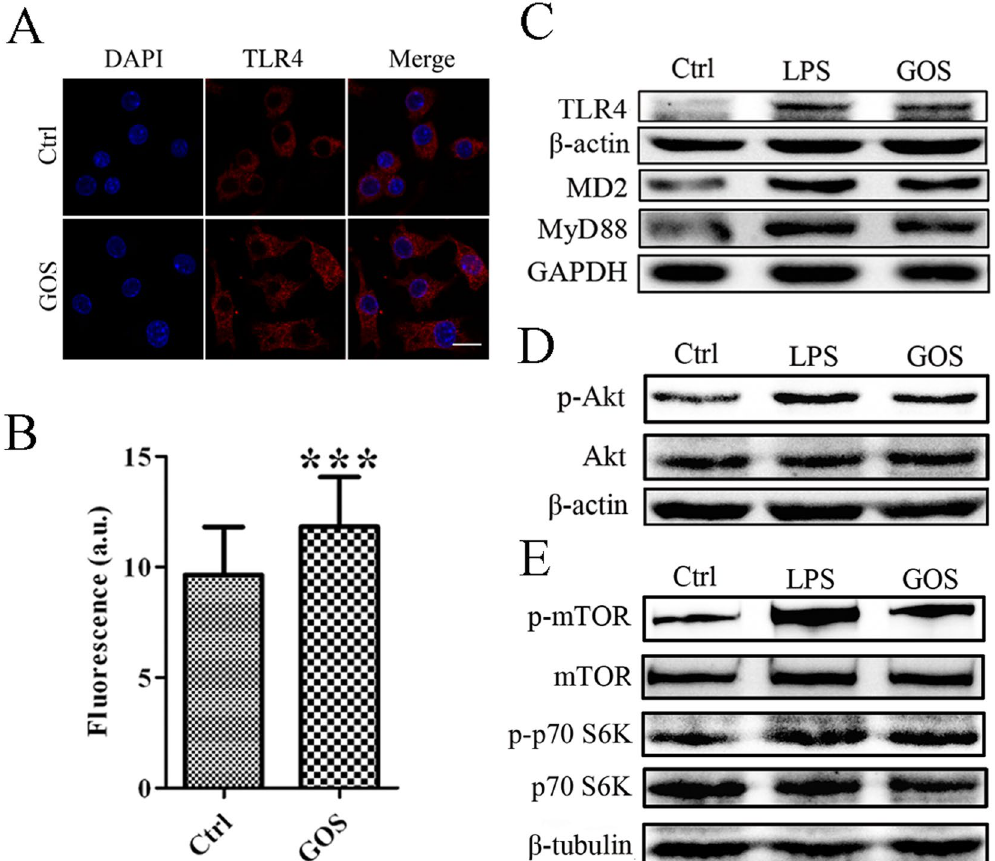
Figure 2. GOS increases TLR4 expression and stimulates Akt/mTOR activation in RAW264.7 cells. ( A ) RAW264.7 cells were treated with 1 mg/ml GOS for 24 h, and TLR4 expression was evaluated by immunofluorescence analysis using an anti-TLR4 antibody. DAPI was used to label nuclei. Images were observed by laser scanning confocal microscopy (40x). ( B ) The average fluorescence intensity of forty cells of each treatment group was measured using ImageJ software. ( C ) RAW264.7 cells were incubated with LPS (1 μ g/ ml, as a positive control) and GOS (1 mg/ml) for 24 h. The protein expression of TLR4, MD2 and MyD88 was detected by Western blotting. ( D ) Cells were treated with 1 μ g/ml LPS (positive control) or 1 mg/ml GOS for 24 h, and phosphorylated and nonphosphorylated Akt were detected by Western blotting. ( E ) Phosphorylation of mTOR and p70 S6K was analyzed by Western blotting. The full-length western blots were presented in supplementary information. Representative images and results from three independent experiments are shown. *** P <